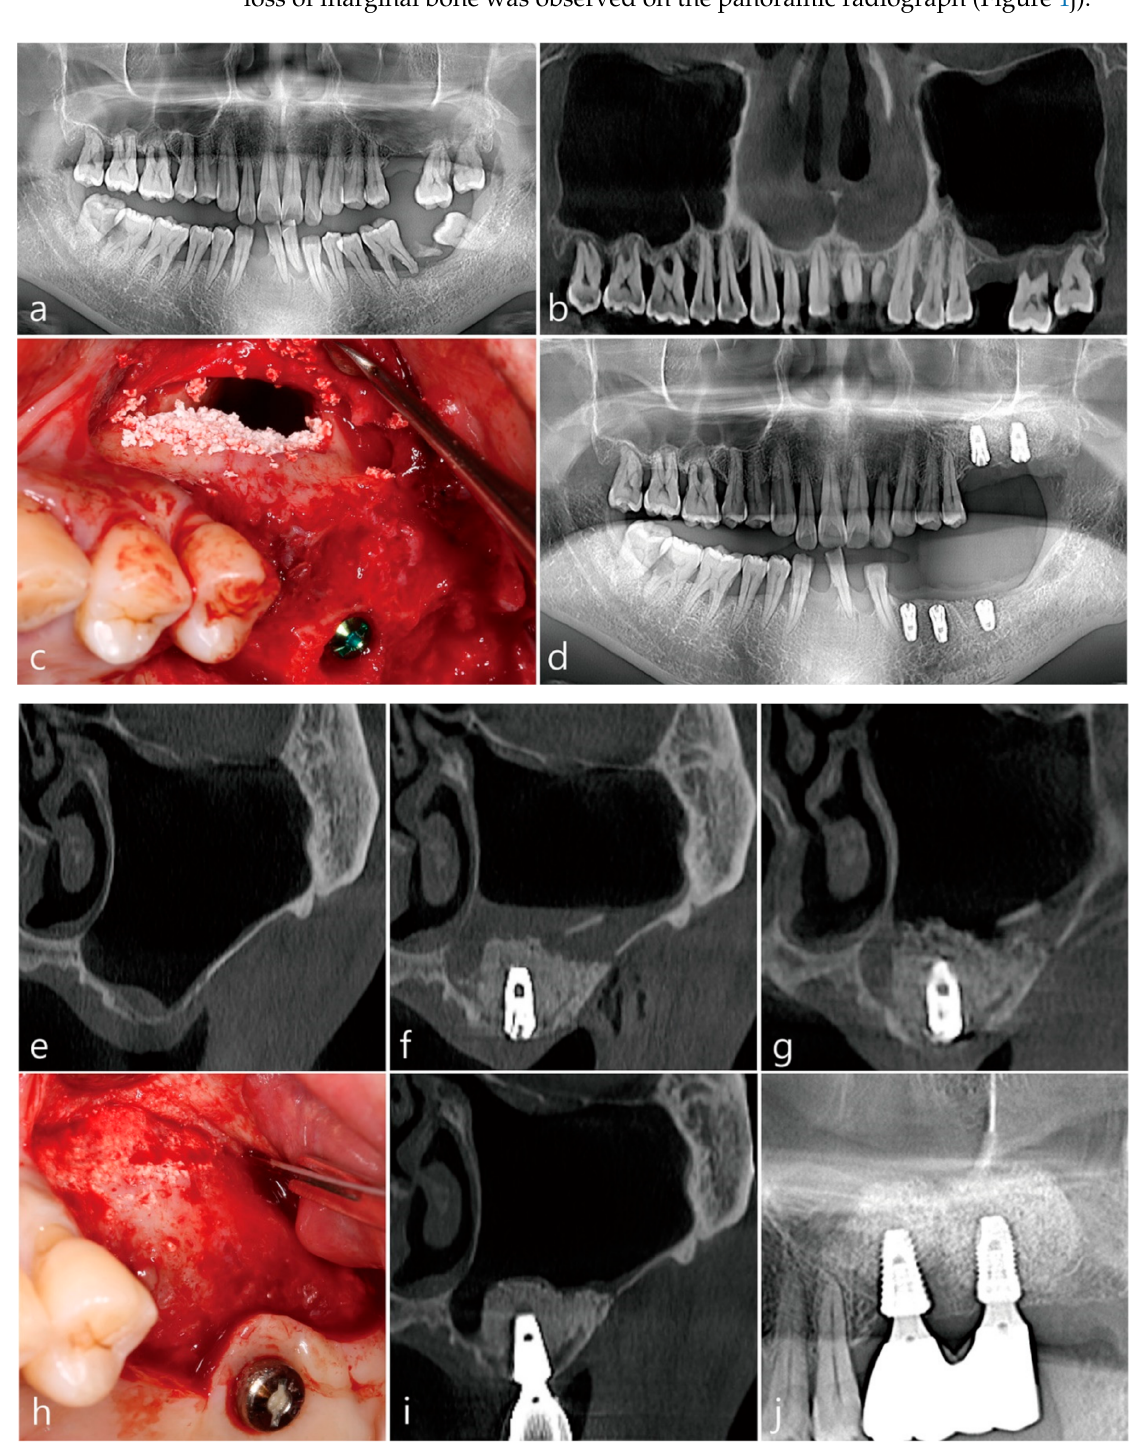
Figure 1. Case 1. Preoperative and postoperative radiographic findings of case 1, and clinical pictures of the open lateral window technique. ( a ) On the preoperative panoramic radiograph, advanced